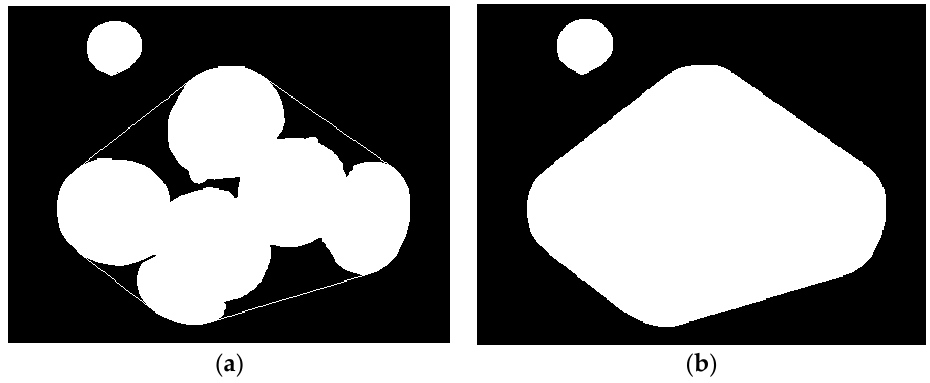
Figure 5. Overlapping Agaricus bisporus convex shell. ( a ) Convex hull curve extraction; ( b ) convex hull enclosed area.